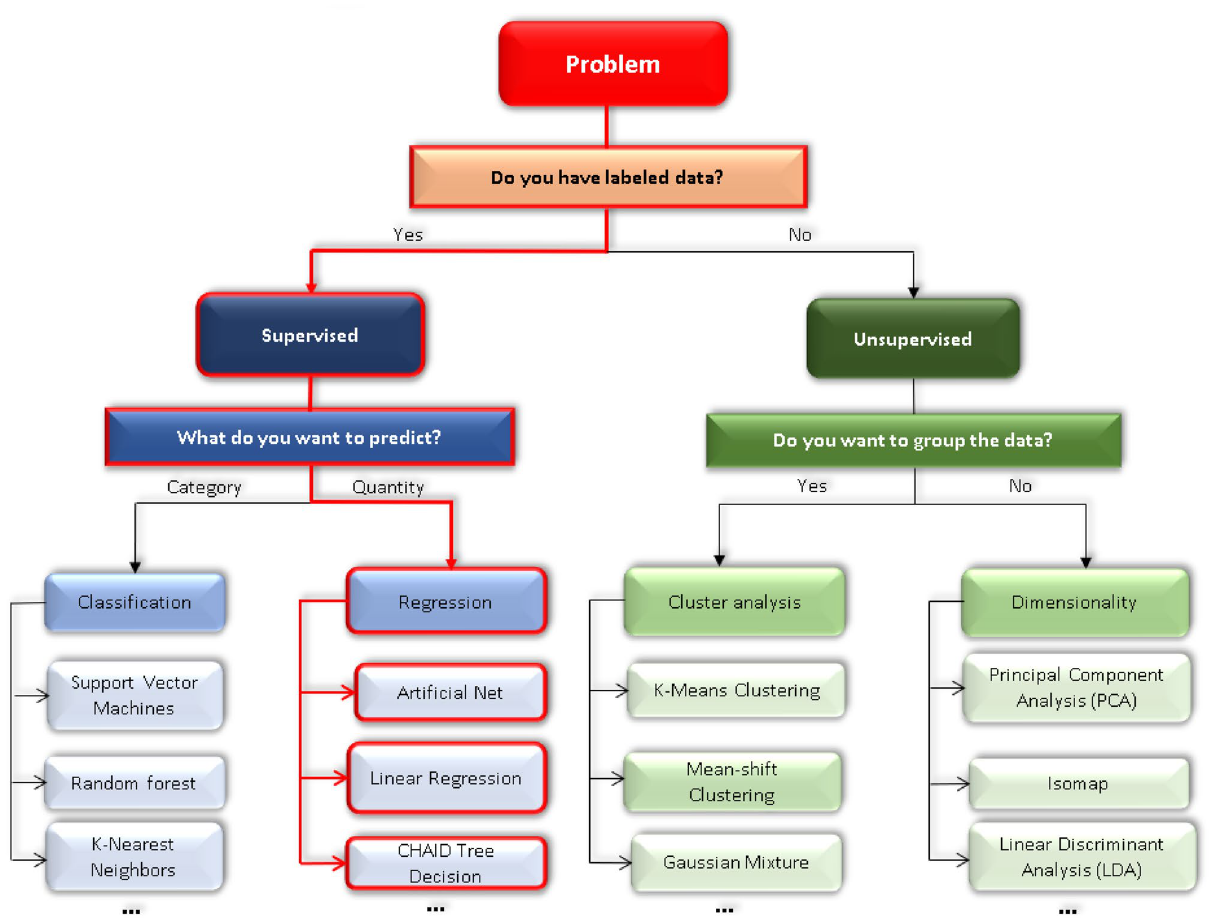
Figure 1. Various categories of machine learning